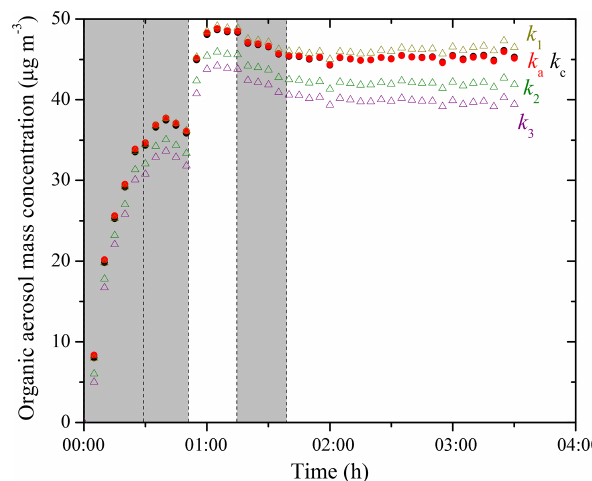
Figure 4. (a) The SMPS-measured particle volume concentration time series for an aging experiment (Exp. 3) with three colored peri- ods used to derive the corresponding size-independent particle wall- loss rate constants, k 1 – k 3 (Eq. 2). The grey area indicates that the chamber was dark. The dashed lines mark the beginning and the end of bubbling HONO into the chamber twice; (b) the averaged parti- cle volume size distribution over the three periods used to develop k 1 – k 3 based on the SMPS measurement for Exp. 3; (c) the size- dependent particle wall-loss rate constants determined from SMPS- measured particle number concentration from Period 1 for Exp. 3. Only k a values (red symbols) with an R 2 > 0 . 5 are shown. The er- ror bars correspond to ± 1 standard deviation. The grey area is the uncertainty associated with k c (black symbols).